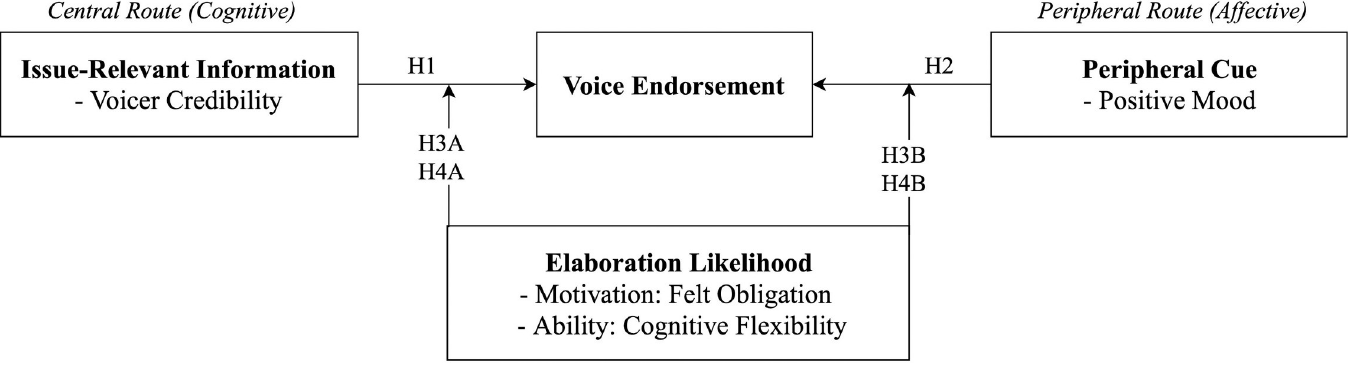
Fig 1. An elaboration likelihood model of voice